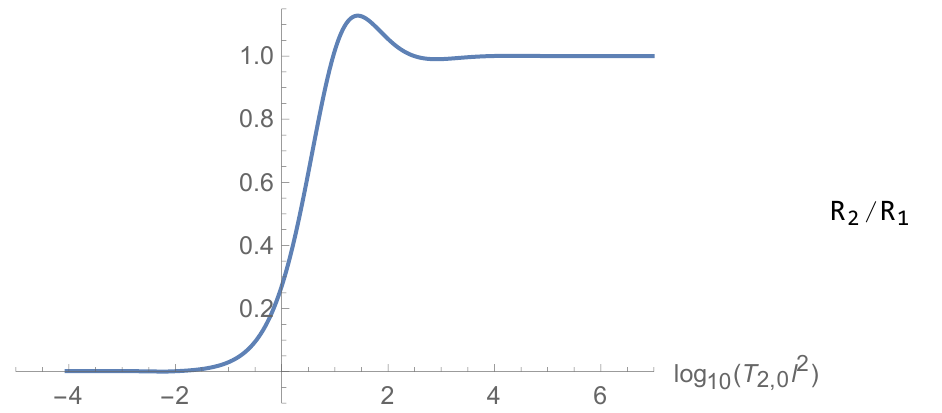
Figure 6 . R 2 ( T 2 ; 0 ‘ 2 ) in the case where the sphere 1 shrinks. The ratio is independent of u 0 R 1